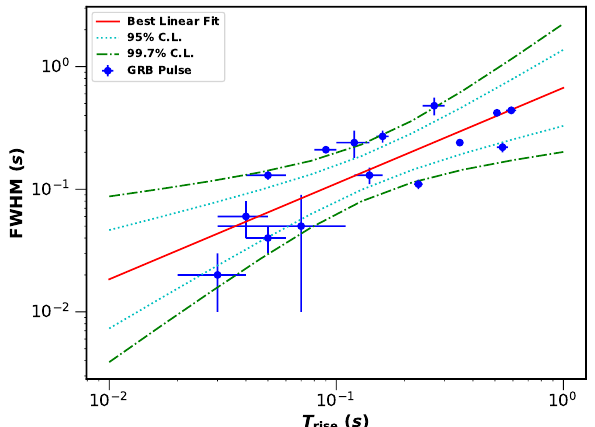
Figure 2. Correlation of the rising time ( T rise ) and the full width at half maxima (FWHM) of individual pulses in all selected short GRBs. 95% and 99.7% confidence leverls are plotted by light blue dotted line and green dashed line